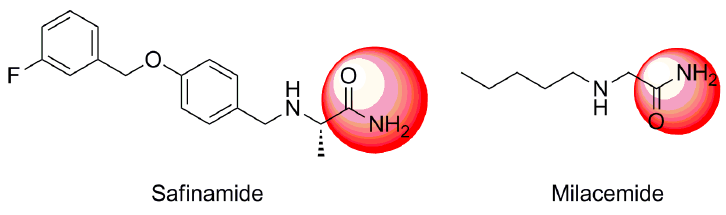
Figure 1. Examples of known monoamine oxidase (MAO) inhibitors bearing an acetamide